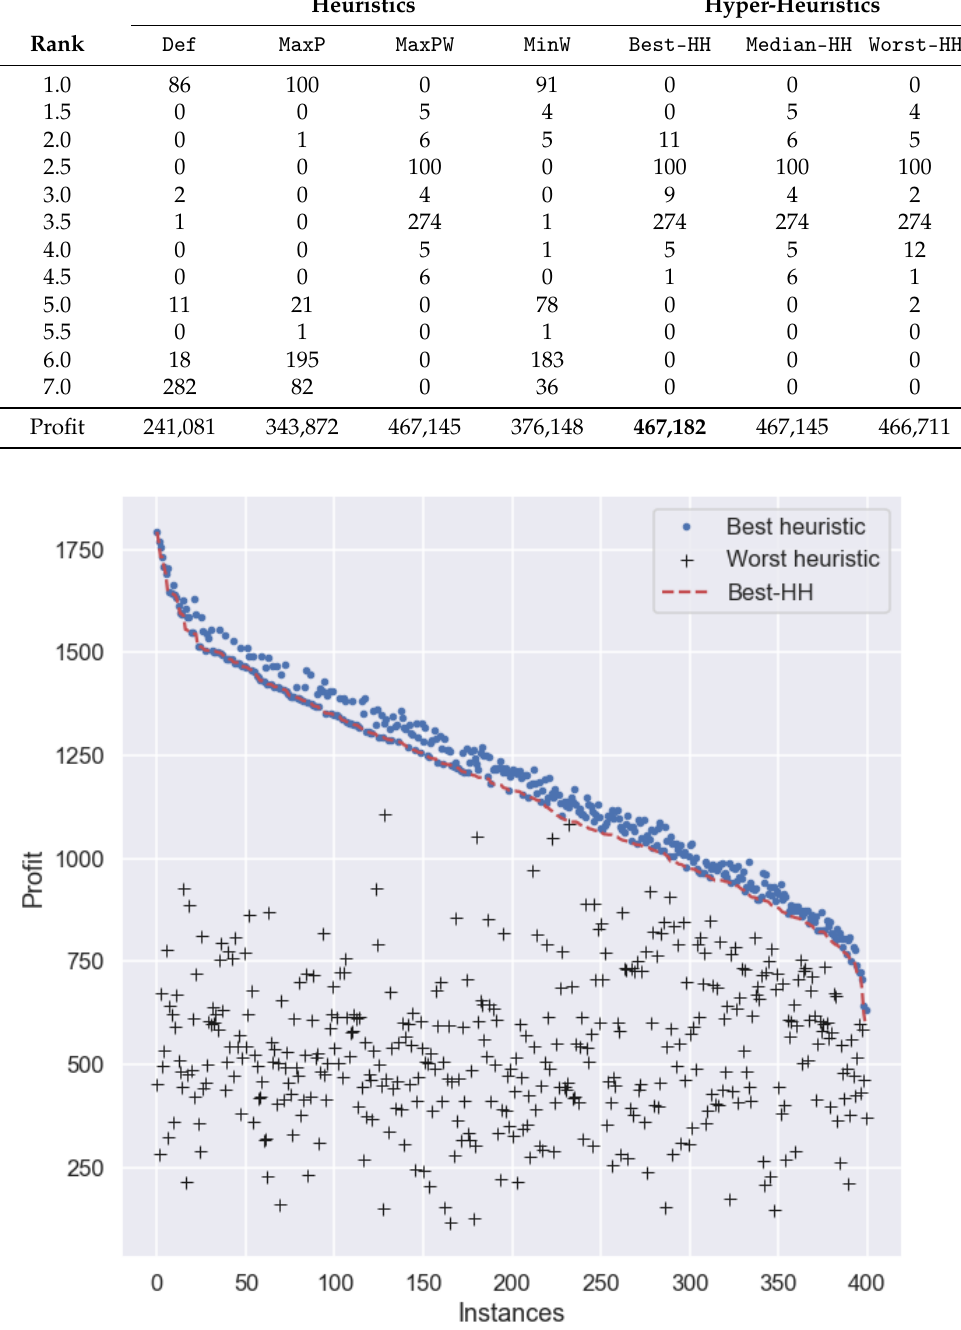
Figure 3. Profit per instance obtained by the best hyper-heuristic trained on 60% of set α 1 and the best and worst heuristic per instance on set α 2